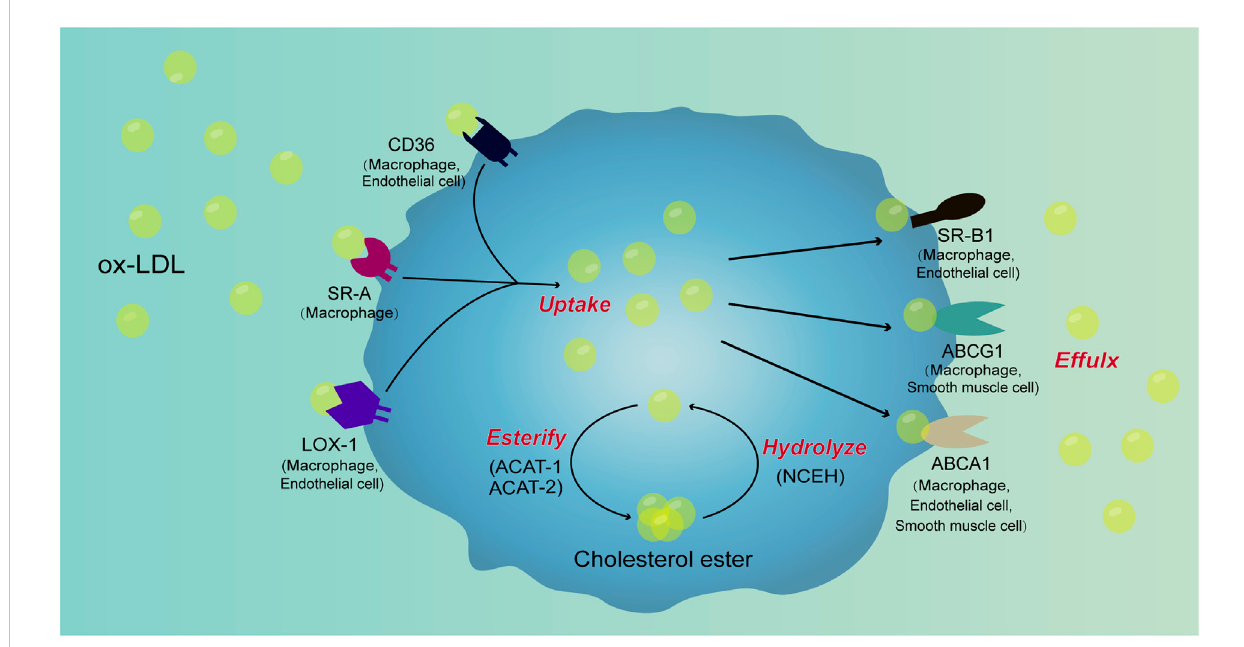
Signal pathways involved in cell foaming. Ox-LDL is taken up by macrophages through scavenger receptors such as CD36, SR-A, and LOX-1. After uptake of ox-LDL, a portion of ox-LDL is converted to cholesterol esters by ACAT-1 and ACAT-2, cholesterol esters are hydrolyzed to ox-LDL by NCEH. Ox-LDL produced by the hydrolysis of cholesterol esters is excreted from the cells along with free ox-LDL in the cells through receptors such as SR-B1, ABCG1,andABCA1.Whenthelipiduptakeofmacrophagesisnotcontrolled,theproductionofcholesterolestersincreasesandhydrolysisandef fl ux are blocked, cholesterol esters will accumulate in cells to form foam cells. Thereare scavengerreceptorssuch as CD36, SR-A, LOX-1, SR-B1, ABCG1 and ABCA1inmacrophages.InVSMCs,ABCA1andABCG1arepresent,whileCD36,LOX-1,SR-B1andABCG1arepresentinECs.However,themechanism of lipid metabolism of VSMCs and ECs and their contribution in foam cell formation require further